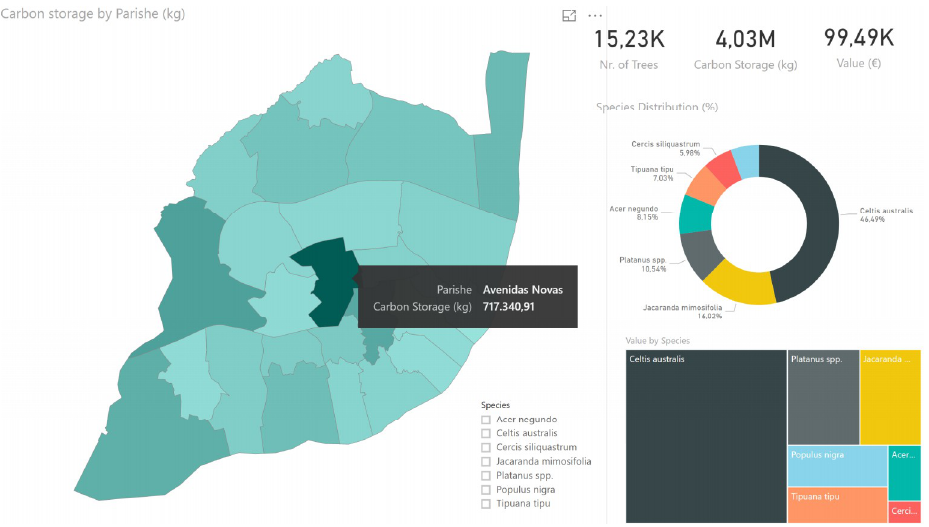
Figure 12. Lisbon trees carbon monitor dashboard.